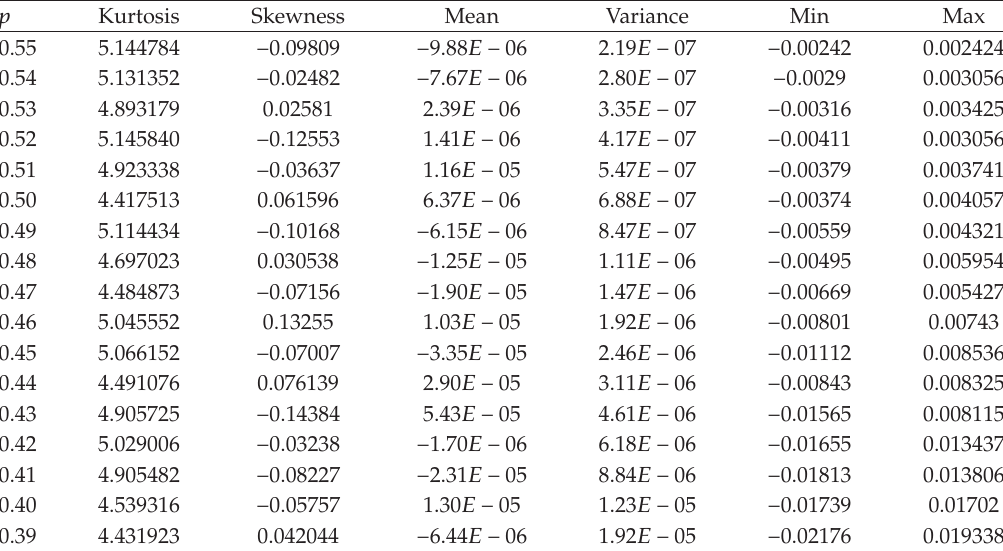
Table 2: The analysis of the price model for di ff erent intensity values p